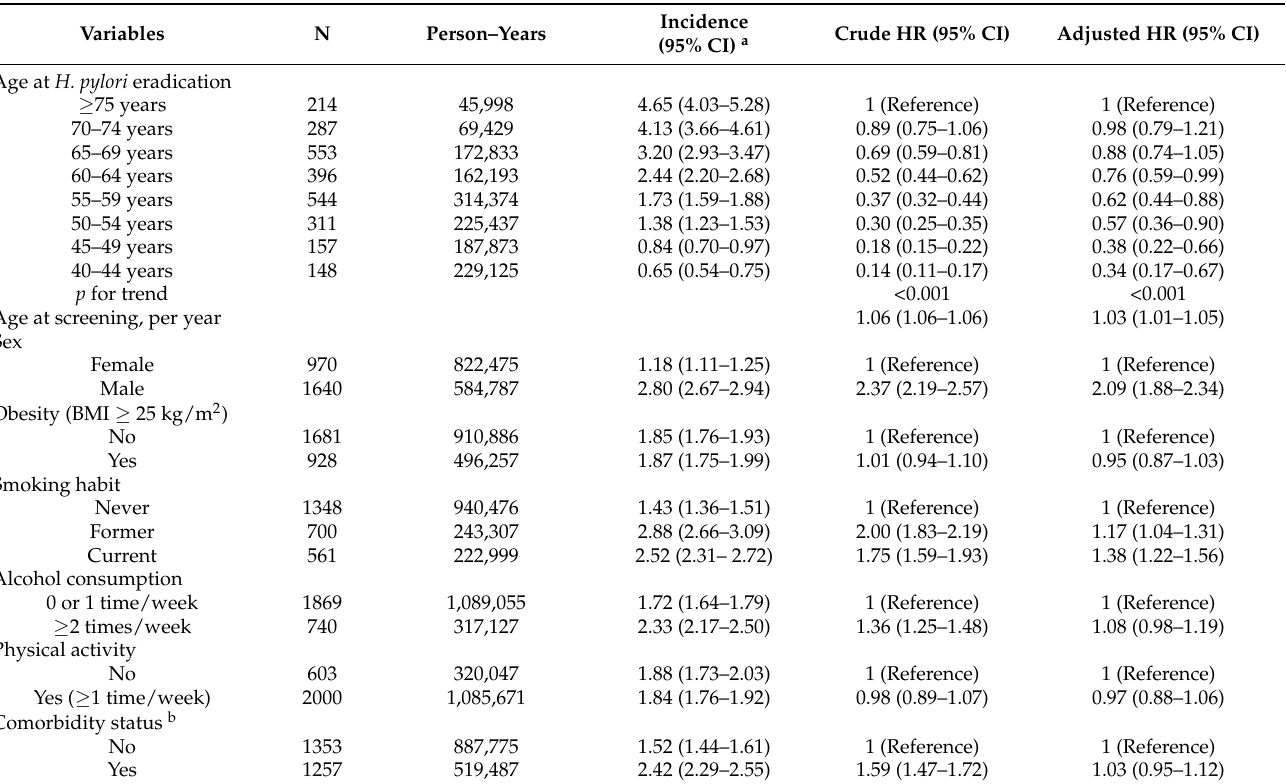
Table 2. Risk of gastric cancer according to age at H. pylori eradication in patients with a family history of gastric cancer.